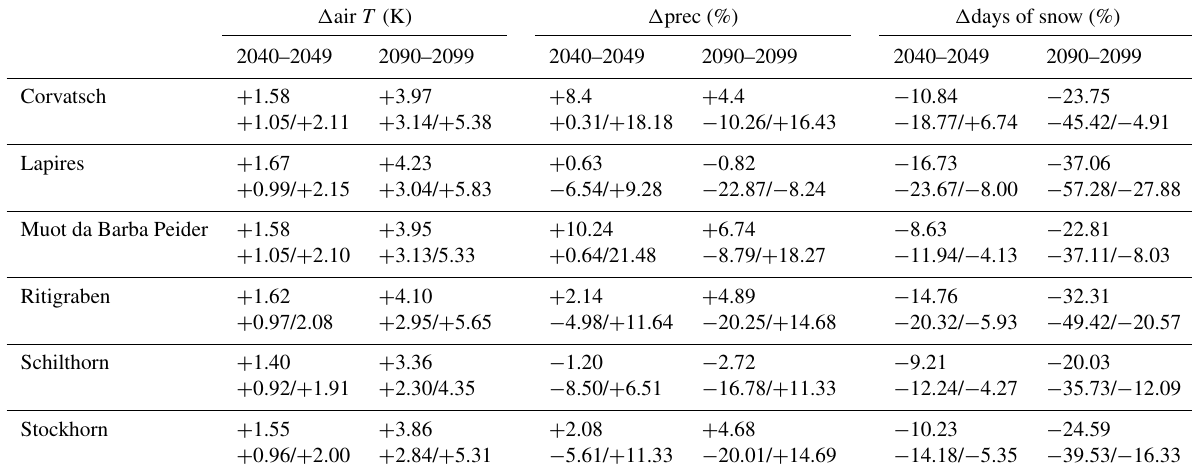
Table 3. Summary of changes projected for two different decades (2040–2049 and 2090–2099): mean of 13 GCM/RCM chains for change in mean air temperature, in mean precipitation sum and in simulated snow cover duration (number of days per year with snow 0.1m) compared to the 2000–2010